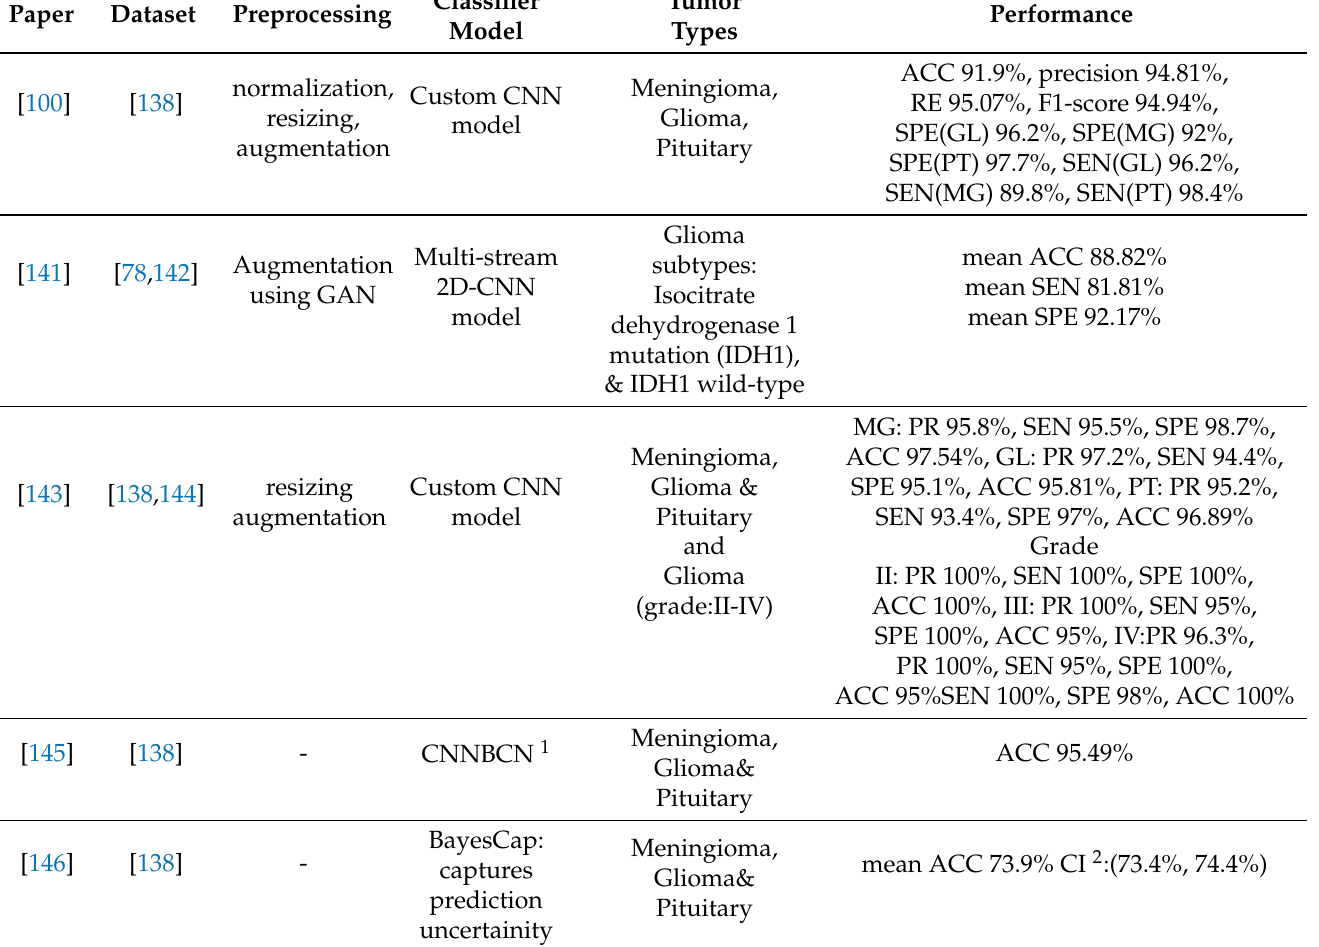
Table 7. Summary of deep learning based brain tumor classification